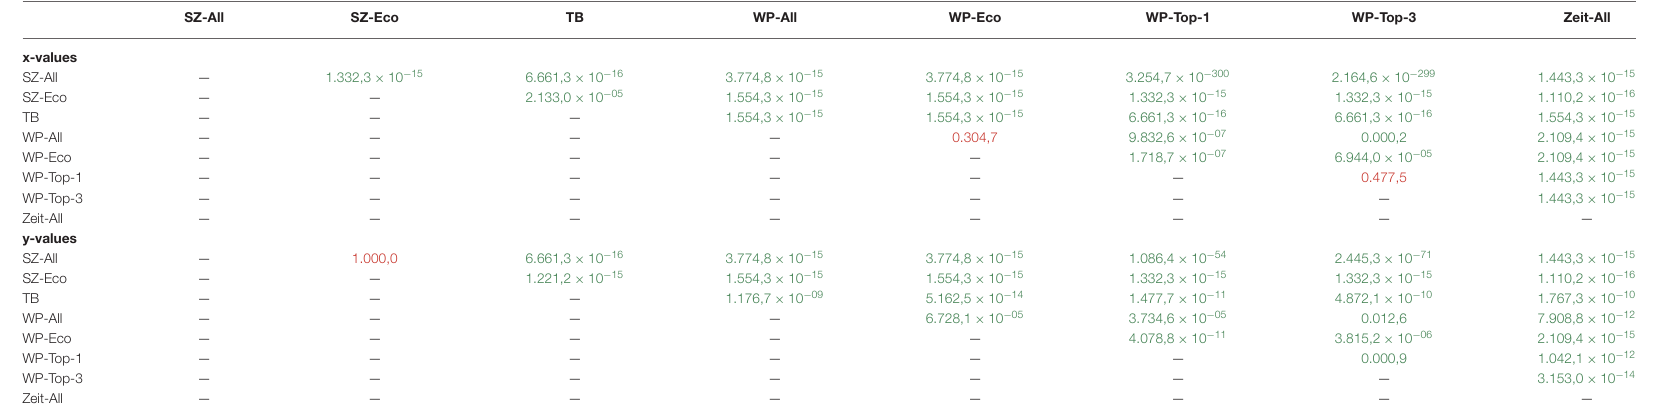
TABLE 7 | P -values of the Kolmogorov-Smirnov goodness-of-fit test applied to the pairwise combinations of the x and y values of the distributions in Figure 9 . SZ-All SZ-Eco TB WP-All WP-Eco WP-Top-1 WP-Top-3 Zeit-All x-values SZ-All